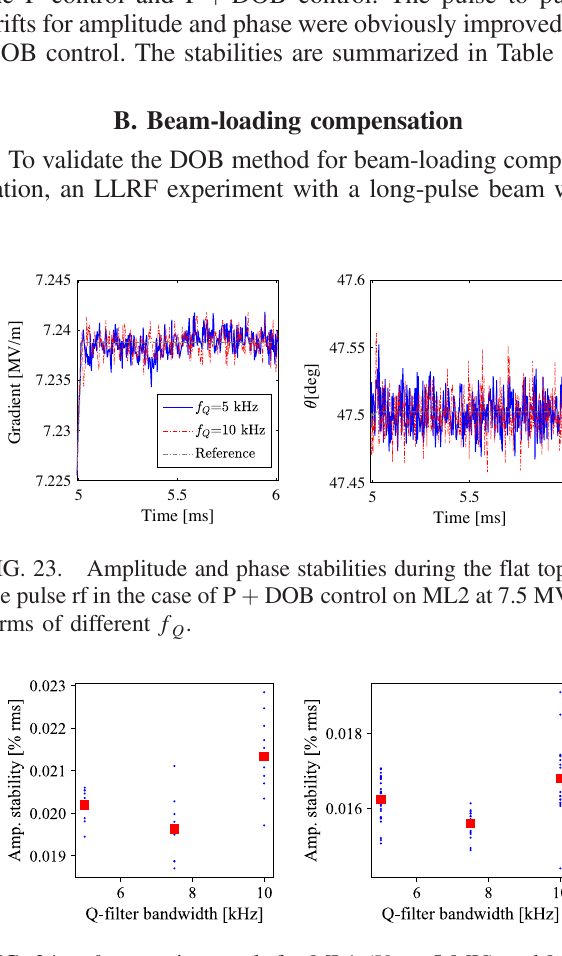
FIG. 24. f Q -scanning result for ML1 ( V c ¼ 5 MV) and ML2 ( V c ¼ 7 . 5 MV). f Q ¼ 7 . 5 MV is determined as the optimal bandwidth according to amplitude